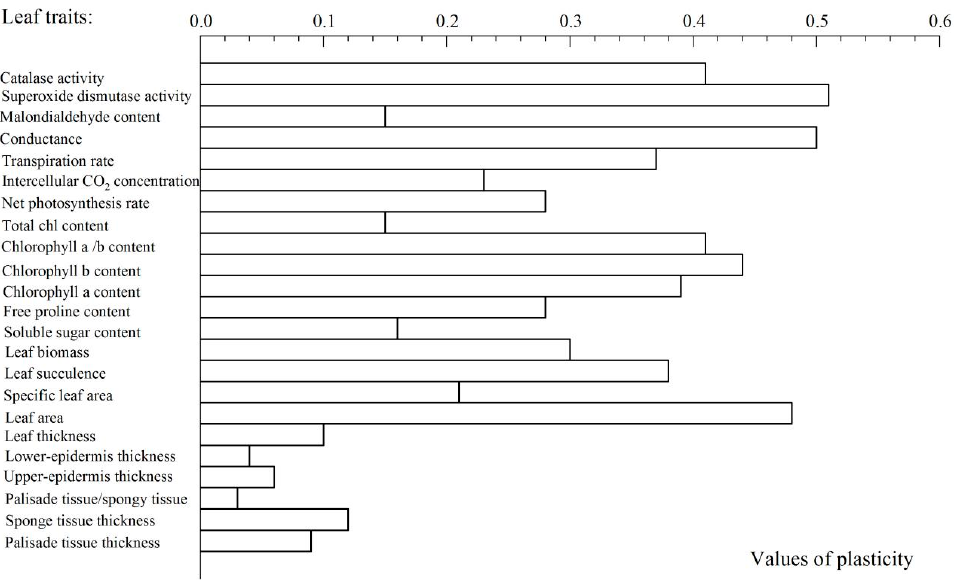
Figure 5. Plasticity values of different characteristics.